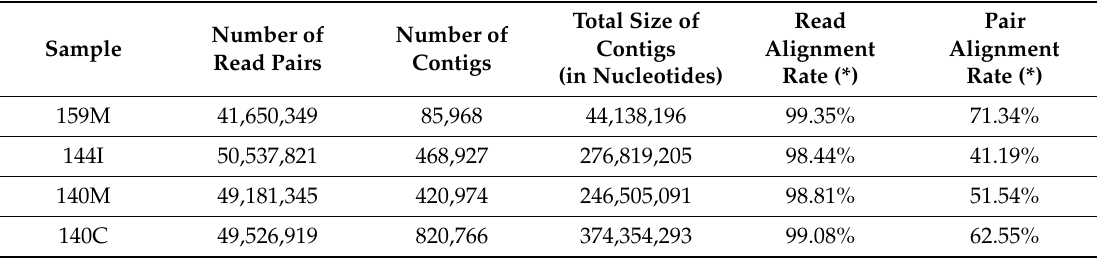
Table 1. Sequencing and alignment statistics. RNA was extracted from brain (140C), muscle (159M (symptomatic hornet), 140M), or gut